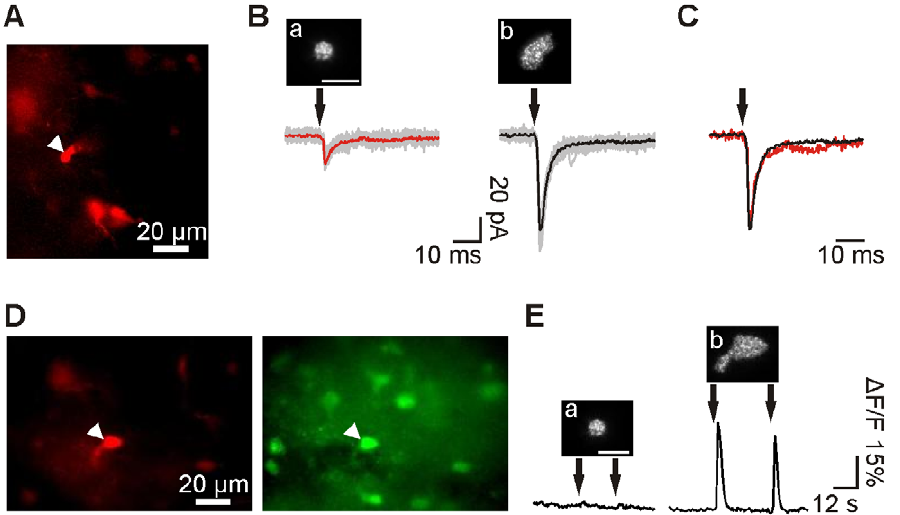
Figure 6. Holographic photostimulation of NG2 cells. A. Red fluorescence image of a target DsRed + NG2 cell (arrowhead) in a hippocampal slice of NG2-DsRed transgenic mice. B. Photolysis-evoked currents elicited in the same cell held at 2 70 mV upon illumination with a 5 m m spot (a) and shaped pattern (b), using the same power density (120 nJ/ m m 2 ). Individual sweeps (gray) and averaged currents (red and black) are shown. C. Normalized photolysis-evoked currents shown in (B). Note the similarity of the kinetics. D. Fluorescence images of a target DsRed + NG2 cell in a OGB- loaded hippocampal slice of NG2-DsRed transgenic mice (arrowheads). E. Variation of intracellular Ca 2 + concentration during photostimulation with a 5 m m spot (a) and shaped pattern (b), using the same power density (100 nJ/ m m 2 ). Scale bars for insets: 10 m